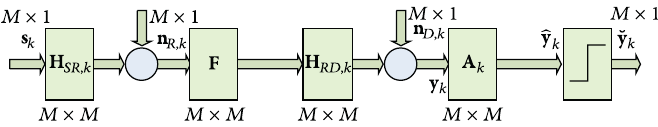
Figure 1: Block diagram of the two-hop relay